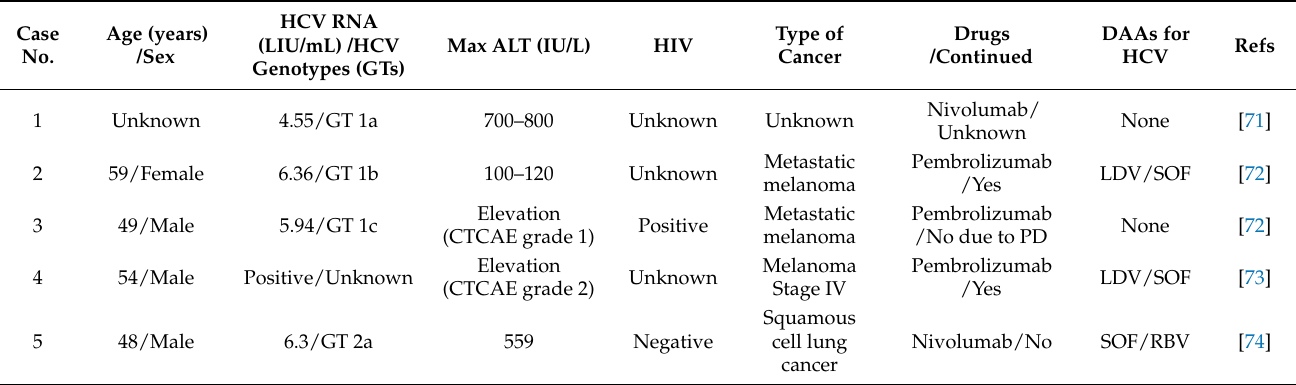
Table 1. Hepatitis C virus-infected patients with acute exacerbation and alanine aminotransferase flare during the use of immune checkpoint